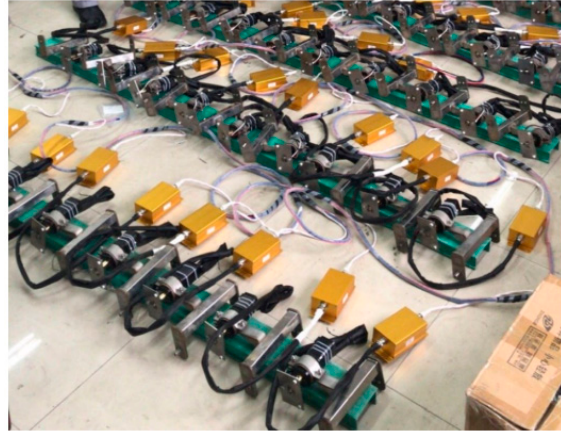
Figure 7. Schematic diagram of offline commissioning of anode rod measuring device.